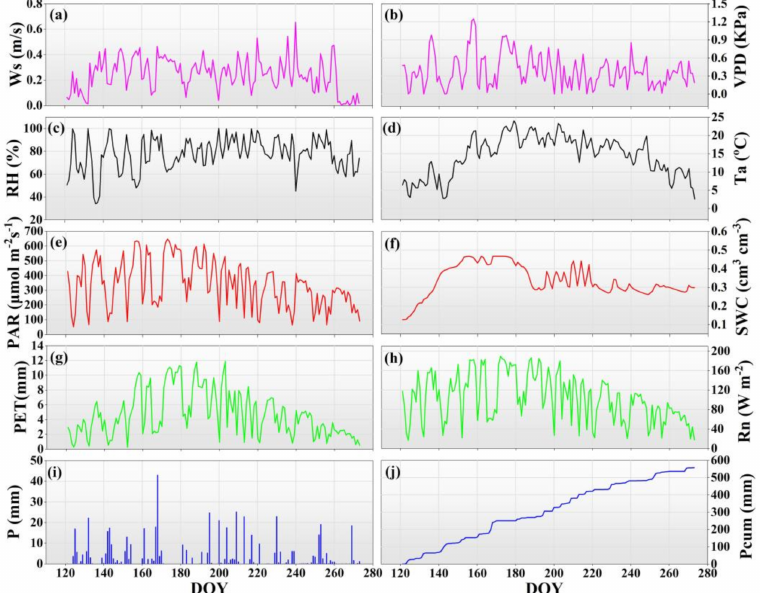
Figure 4. Plots displaying the changes in environmental factors during growing season.